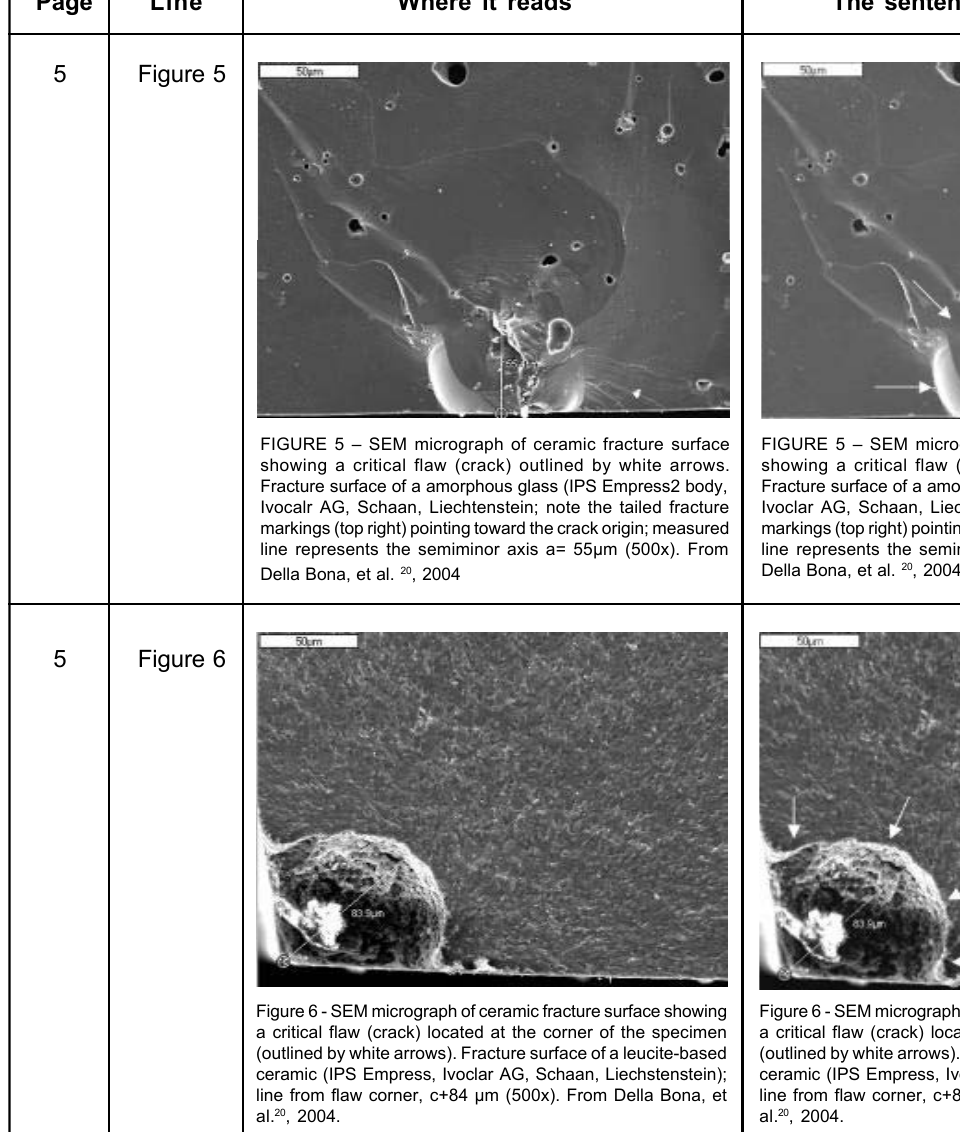
Figure 6 - SEM micrograph of ceramic fracture surface showing a critical flaw (crack) located at the corner of the specimen (outlined by white arrows). Fracture surface of a leucite-based ceramic (IPS Empress, Ivoclar AG, Schaan, Liechstenstein); line from flaw corner, c+84 µm (500x). From Della Bona, et al. 20 ,